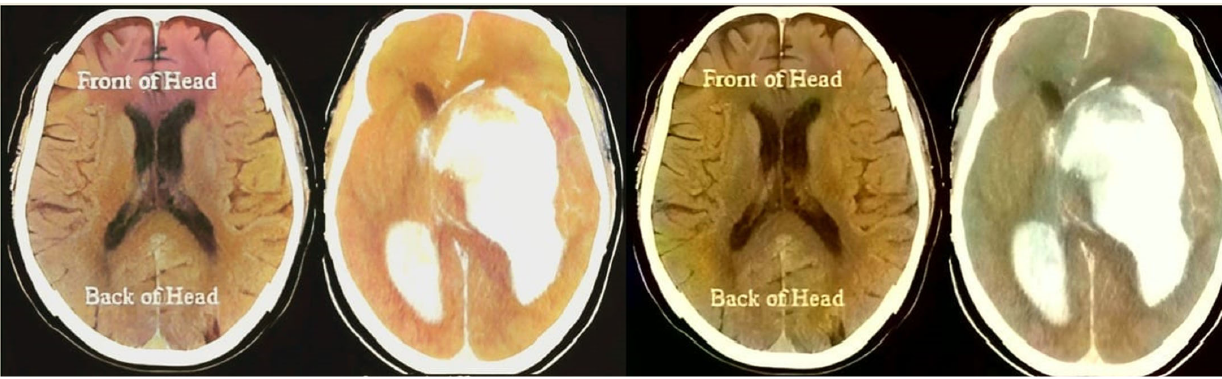
Figure 4. Applying DWT.